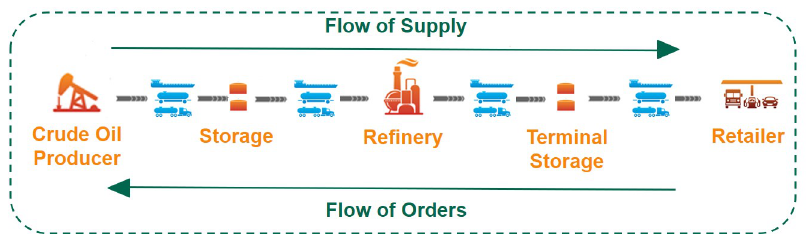
Figure 9. The main layers in the Energy Supply Chain (ESC).